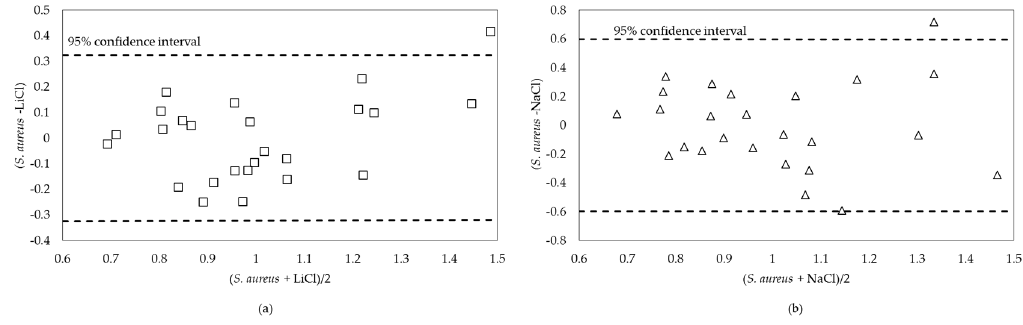
Figure 5. Bland-Altman agreement plots ( a ) S. aureu s vs. LiCl, ( b ) S. aureus vs NaCl.